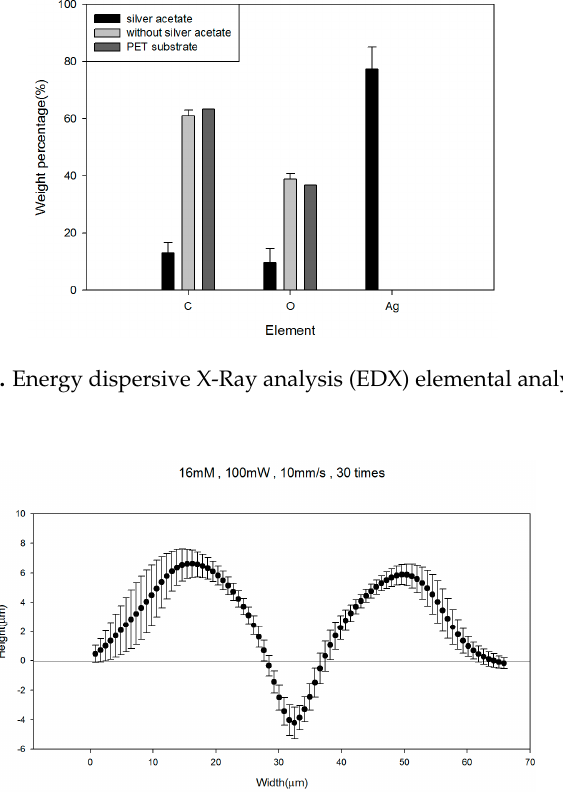
Figure 7. The morphology of the cross section of a silver line fabricated with LDSP (16 mM process solution, 30 laser scans).